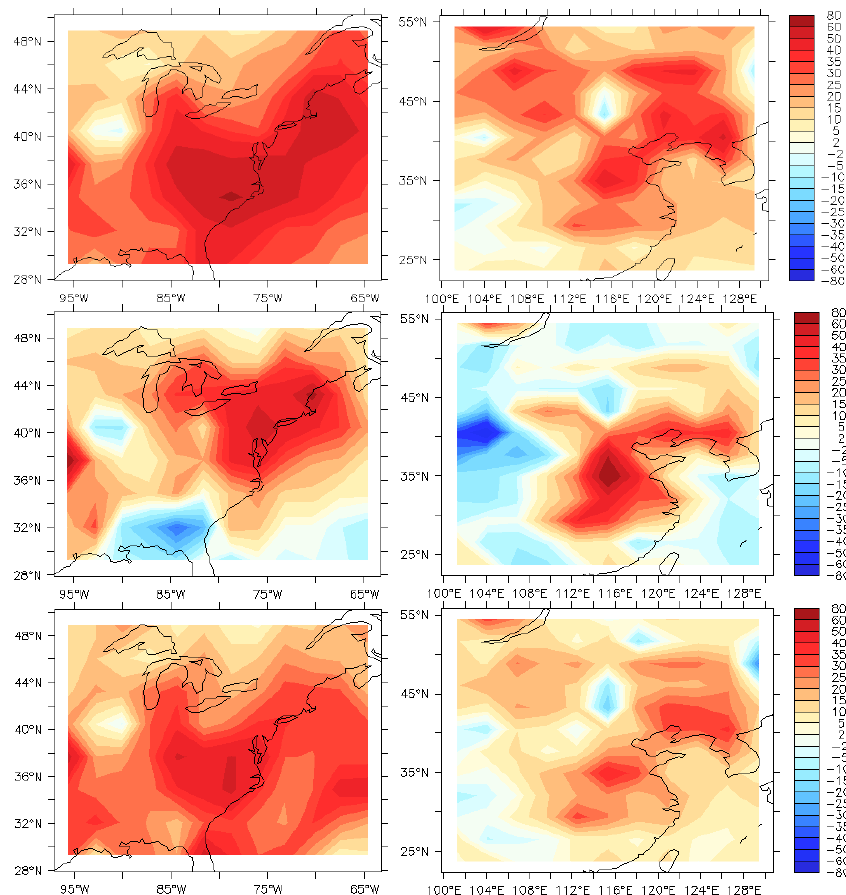
Fig. 5. Simulated monthly average relative changes (%) in the aerosol (accumulation soluble mode, as) sulphates (upper panels), nitrates (middle panels) and ammonium (lower panels) in the reference run (base_S1) near the surface in January over the eastern US (left) and China (right) due to HONO enhancement in the model